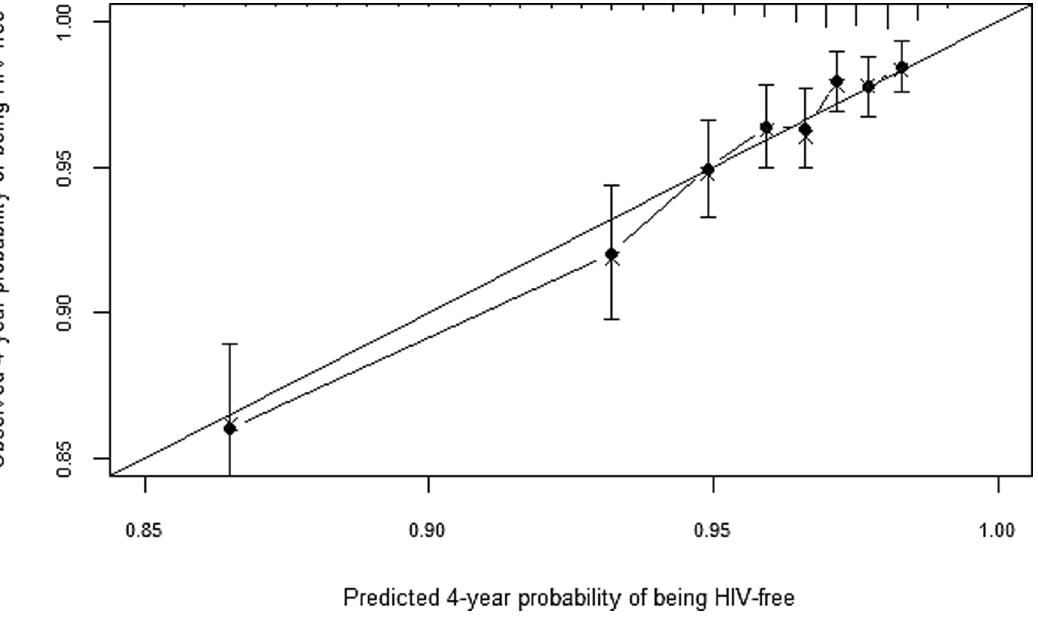
Figure 4. Observed vs predicted probabilities of being HIV-free at 4 years of follow-up. The figure provides bias-corrected calibration of the women’s prediction model.